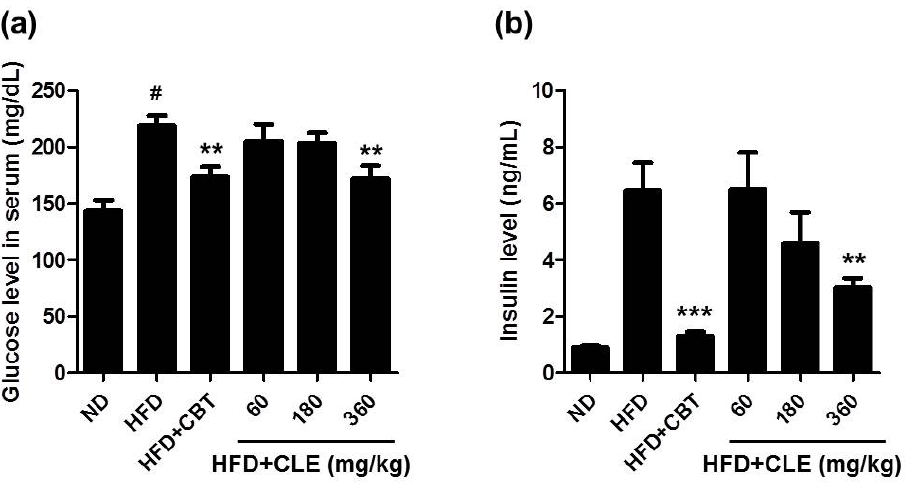
Figure 5. Effect of CLE on serum glucose and insulin levels of mice fed a HFD. ( a ) Serum glucose. ( b ) Serum insulin. Values are the mean ± SEM ( n = 10), # p < 0.05 vs. ND-fed mice, ** p < 0.01, *** p < 0.001 vs. HFD-fed mice. ND: normal chow diet, HFD: 60% high fat diet + vehicle, HFD + CBT: 60% high fat diet + reductil